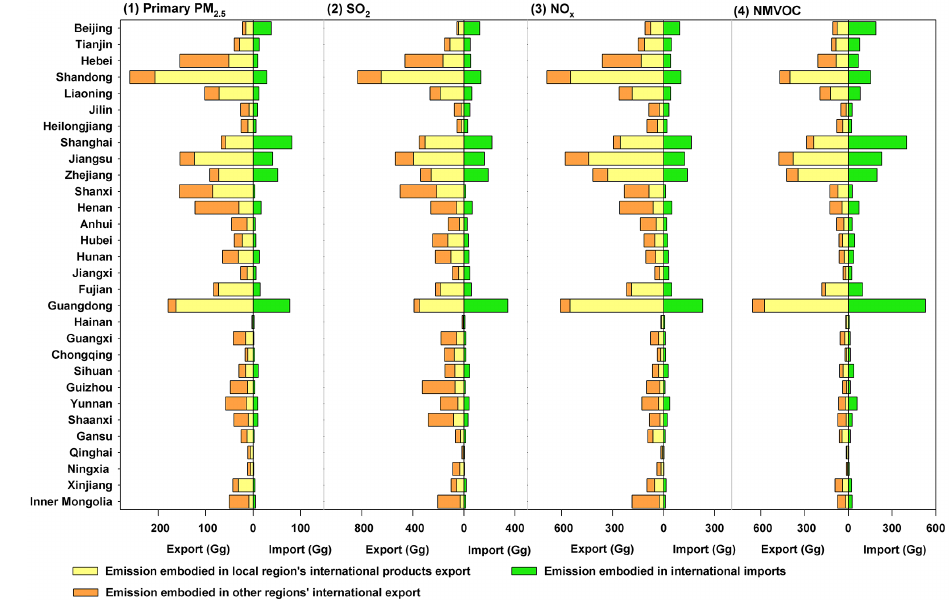
Figure 5. Balance of pollutant emissions embodied in each province’s international